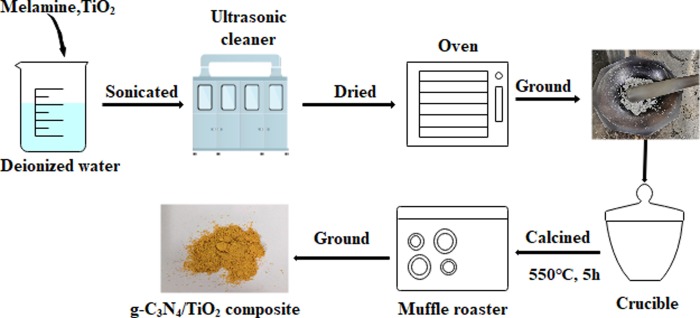
The preparation process of g-C3N4/TiO2 composite.